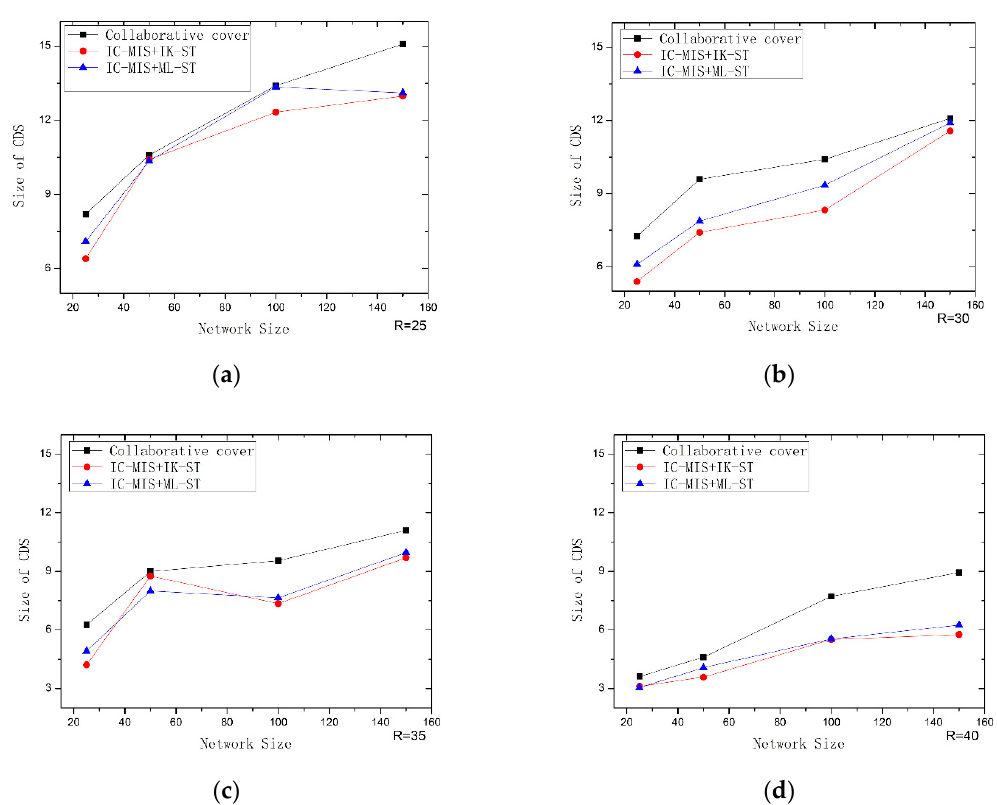
Figure 9. Performance comparison of IC-MIS+IK–ST, IC-MIS+ML-ST with Collaborative coverage: (a) R = 25; (b) R = 30; (c) R = 35; (d) R = 40.